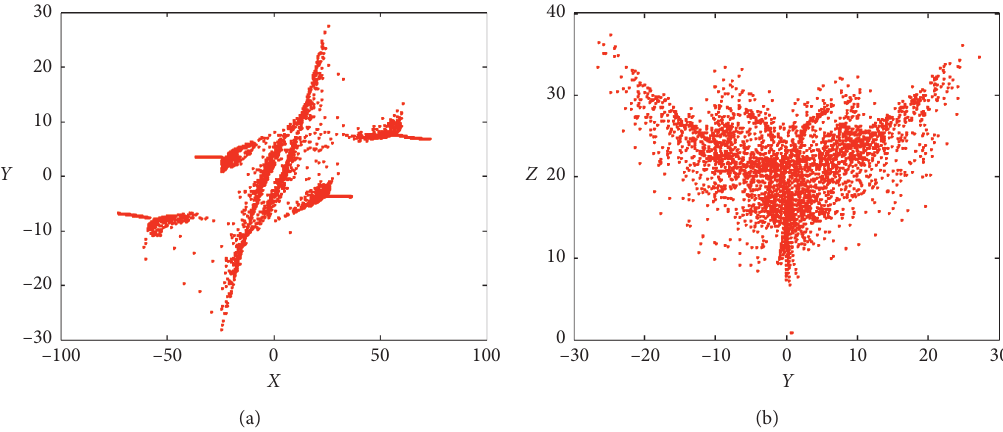
Figure 2: Poincar´e maps of the hyperchaotic attractor of the system (a) on the Z � 30 section and (b) on the X � Y